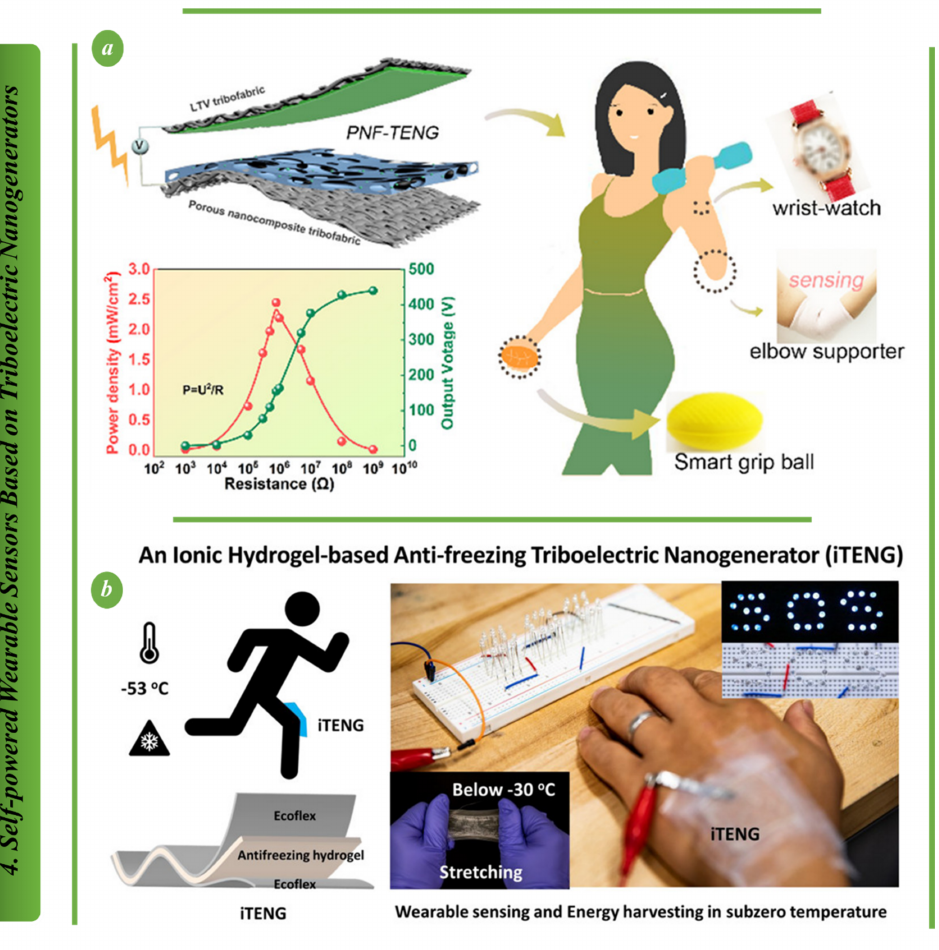
Figure 4. Self-powered wearable sensors based on TENG: ( a ) The PNF-TENG is a self-powered sensor that can also function as a wearable power source [87]. ( b ) The interfacial bonding structure of antifreeze-stretchable iTENG